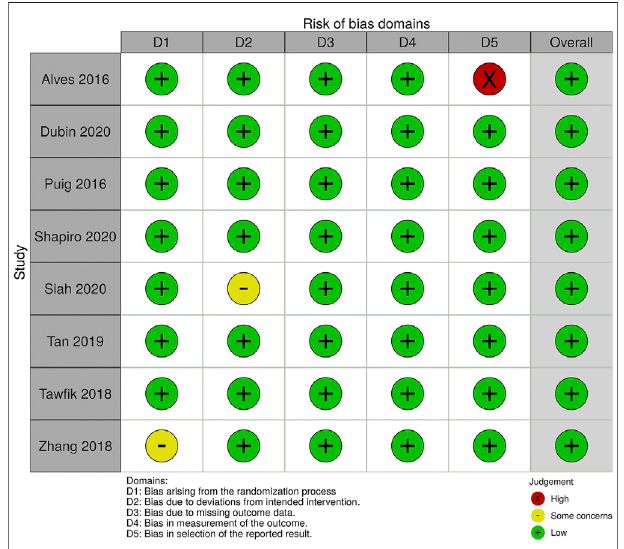
FIGURE 2 | The Risk of Bias evaluation of randomized trials.